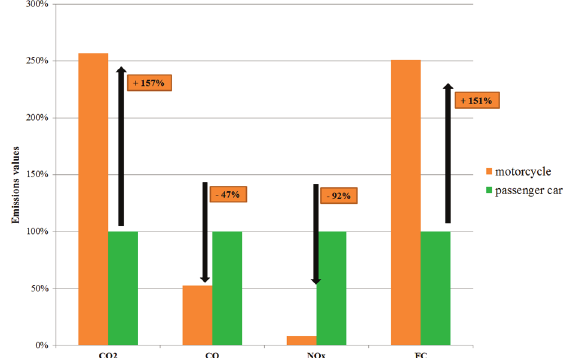
Fig. 8. Exhaust emissions comparison of gaseous compounds and fuel consumption in a passenger-kilometer conversion from the two tested types of